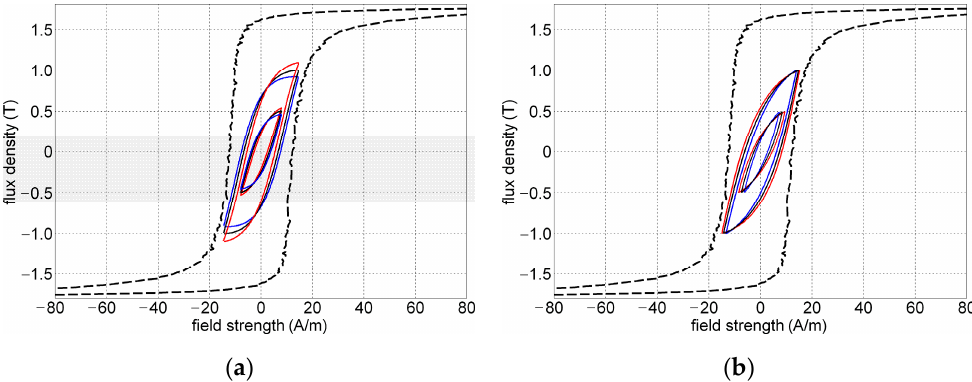
Figure 12. Hysteresis loop of transformer sheet calculated for different values of the exponent: ( a ) p B ; ( b ) p H ; black dashed